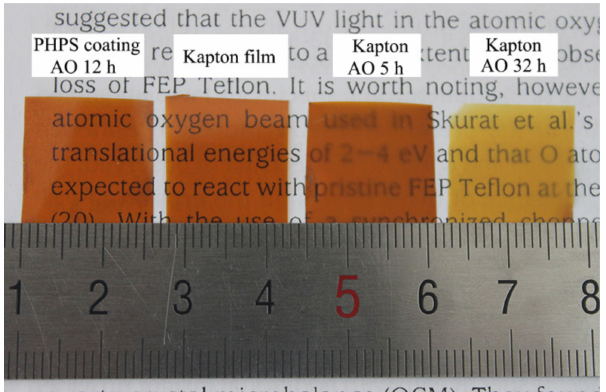
Figure 1. Digital photographs of the PHPS coating exposed to AO for 12 h, pristine Kapton film and Kapton exposed to AO for 5 h and 32